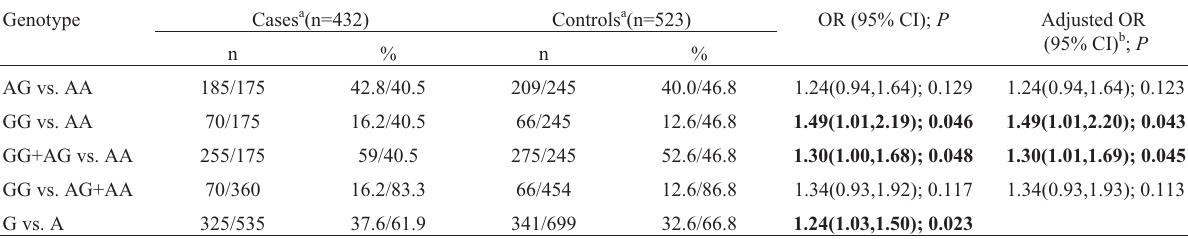
Table 3 - Logistic regression analysis of associations between rs4965833 polymorphism and risk of knee osteoarthritis. Genotype